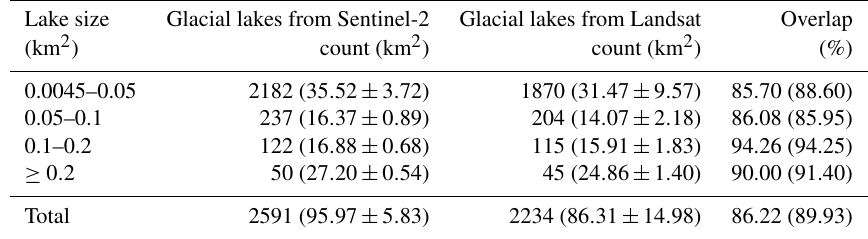
Table 4. Count and area of glacial lakes mapped from Sentinel-2 and Landsat images in 2020 in various size classes.